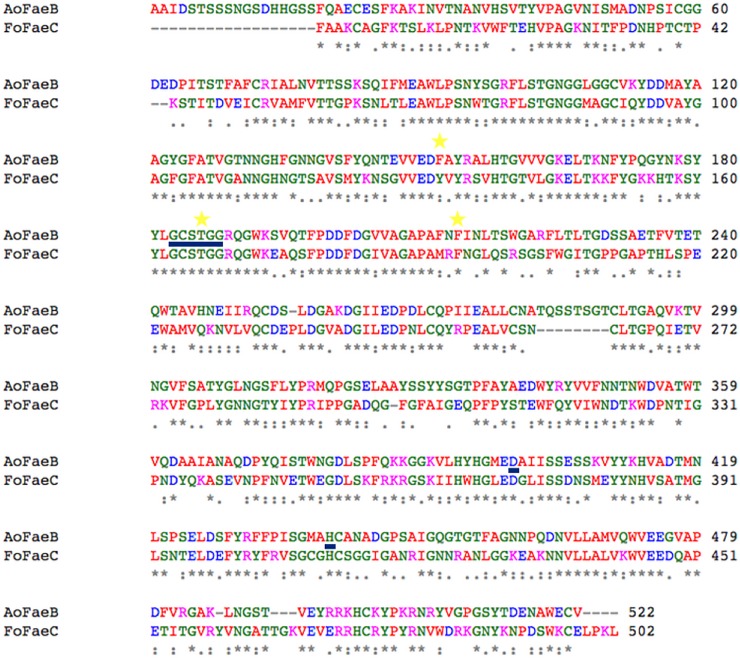
Sequence alignment between AoFaeB and FoFaeC.The catalytic residues are underlined in blue and the potential MSA interacting residues underlined with a star.